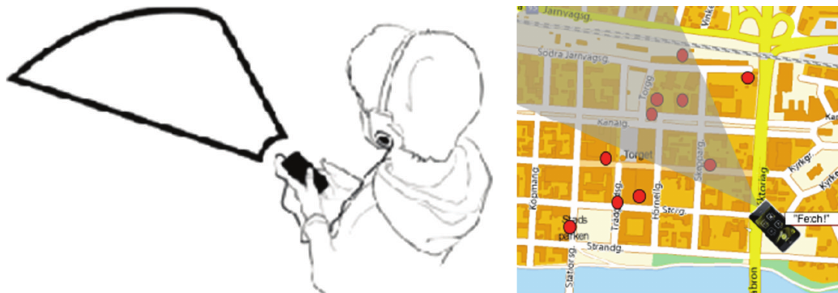
Figure 3: The Fetch function retrieved information about POIs in a 30-degree sector in front of the